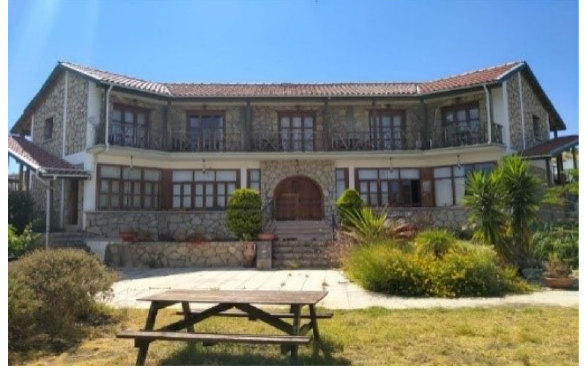
Fig. 7 Ay Phodios Guest House — Komikebir. Example of an adobe structure.